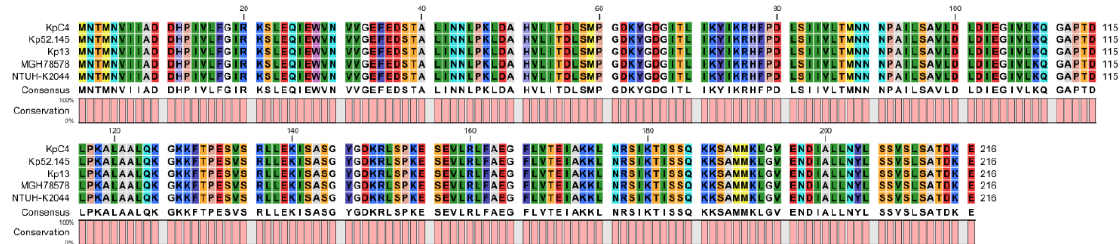
Figure 4. RcsB multi-sequence comparison results of KpC4 and K. pneumoniae clinical strains.